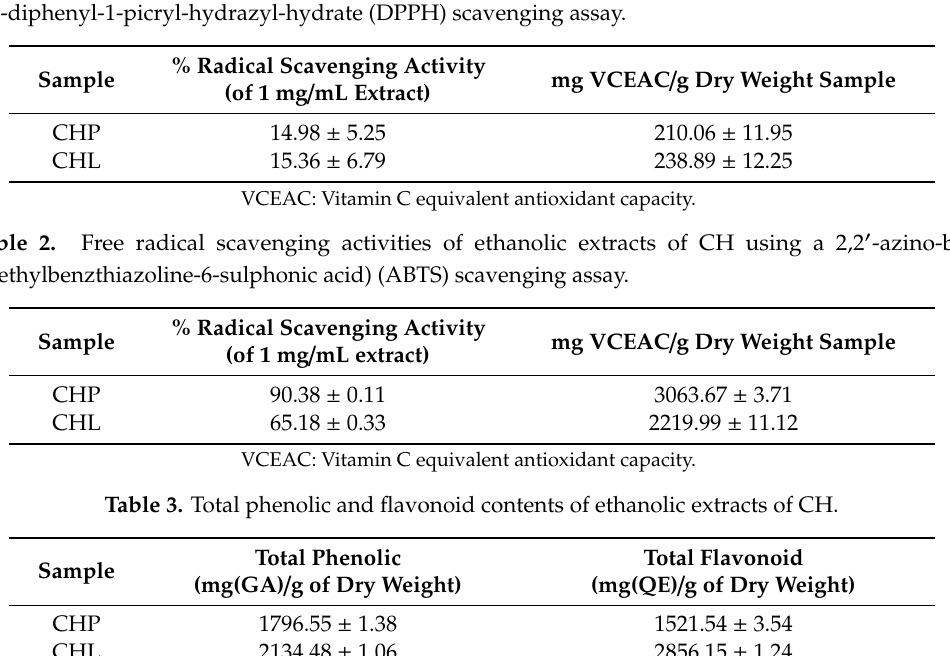
Table 1. Free radical scavenging activities of ethanolic extracts of Citrus hystrix (CH) using a